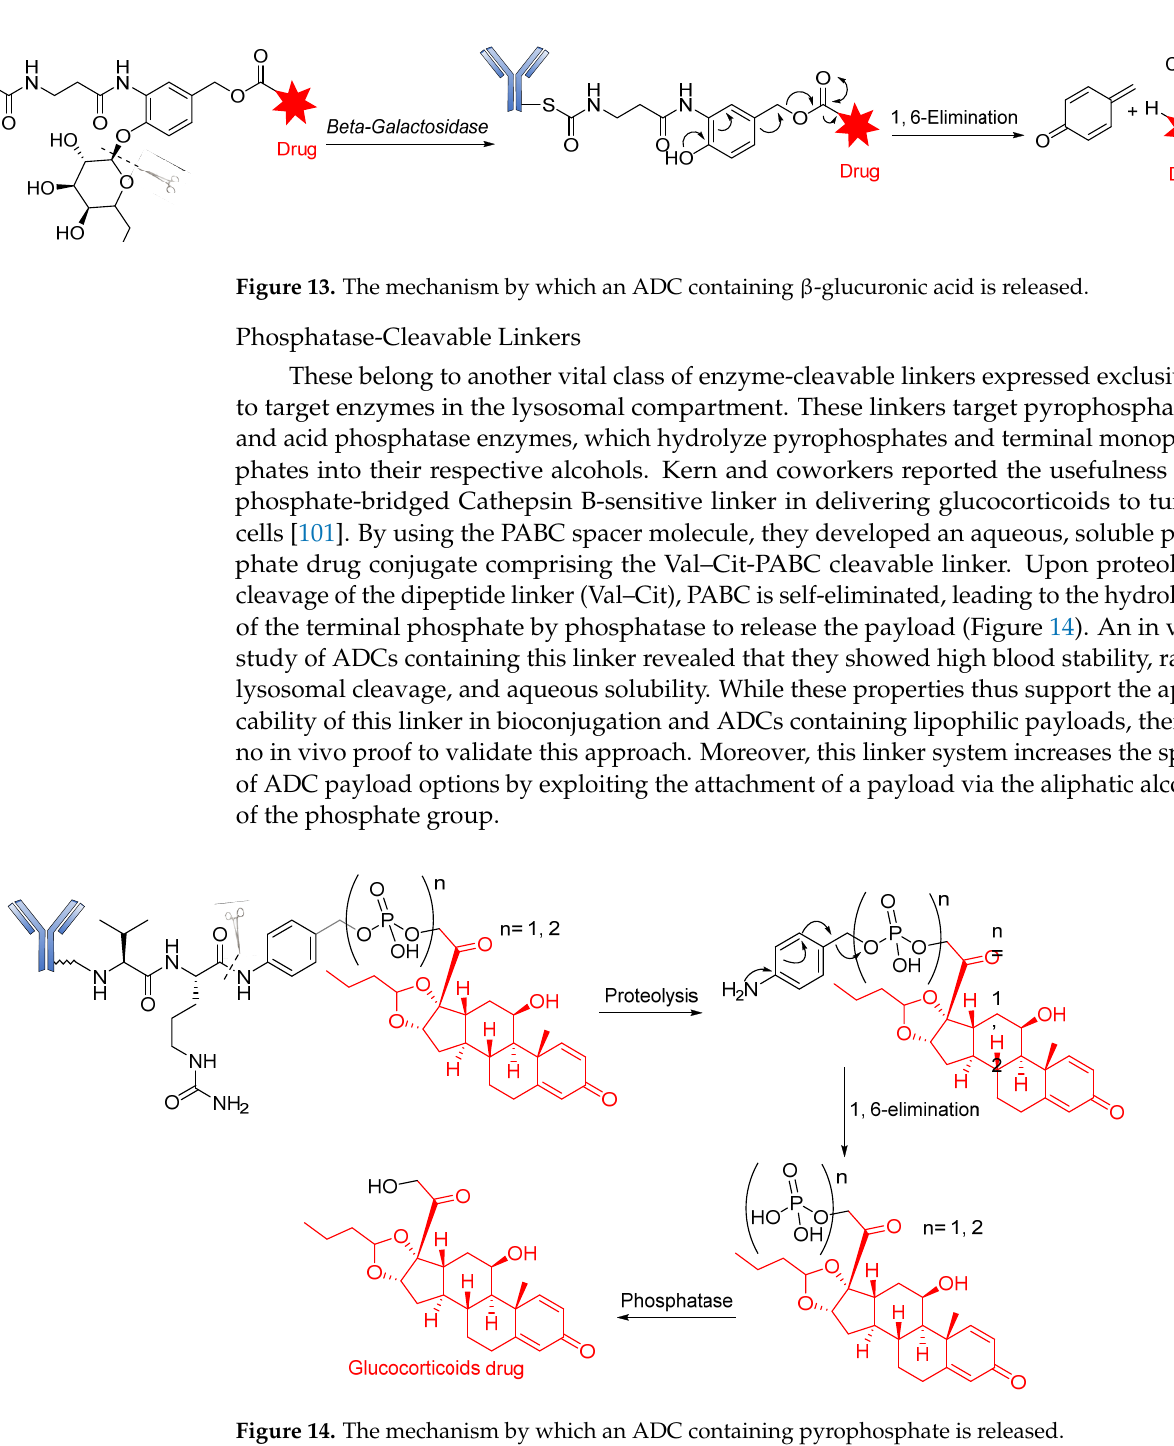
Figure 15. The mechanism by which an ADC containing pyrophosphate is released. 3.2. Non-Cleavable Linkers Non-cleavable linkers are divided into two groups, namely thioether or maleimido- caproyl (MC). They consist of stable bonds that prevent proteolytic cleavage and ensure greater plasma stability than their cleavable counterparts. ADCs containing this type of linker depend on the complete lysosomal enzymatic degradation of the antibody to re- lease payloads after internalization, resulting in the simultaneous detachment of the linker [93,102]. This linker strategy has been successfully explored by Genentech/Immunogen, with clinical approval of Trastuzumab emtansine (Kadcyla/T-DM1). This ADC contains a non-cleavable SMCC ( N -succinimidyl-4-(maleimidomethyl) cyclohexane-1-carboxylate) linker connecting a warhead DM1 cytotoxin to Lys residues of anti-HER2 mAb Trastuzumab (Figure 16). This drug conjugate displayed greater activity than the conven- tional Trastuzumab-DM1, or Trastuzumab conjugated to other maytansinoids via reduc- ible disulfide linkers [56]. Similarly, Monomethyl auristatin F (MMAF) drug conjugates with non-reducible thioether linkers were found to be more stable than Val–Cit conjugates and they also preserved their potency [51]. Of note, non-cleavable linkers allow for the alteration of the chemical properties of the small molecule in order to tune affinity for the transporter or improve potency [51,103]. The comparative advantage of non-cleavable linkers over their cleavable counterparts is their increased plasma stability [104]. Overall,